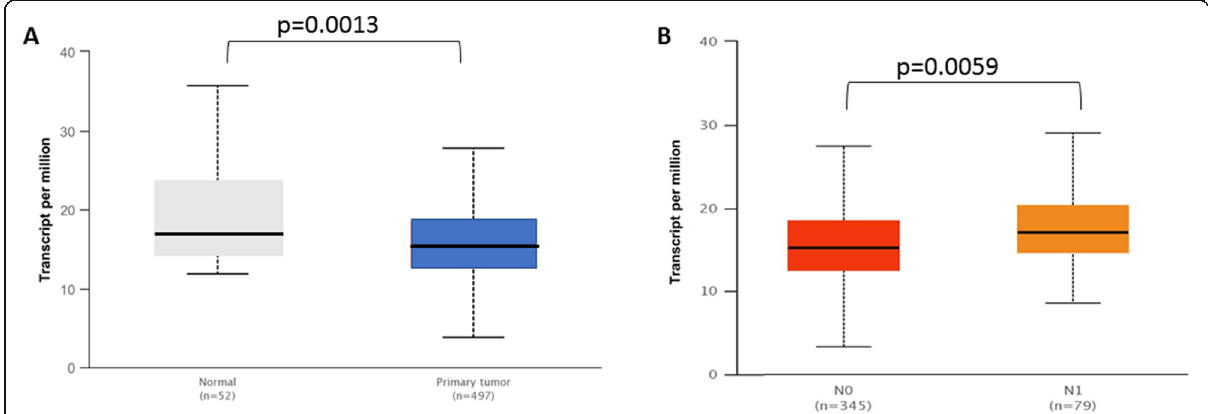
Fig. 3 Gene expression analysis of TERF1 in TCGA cohort. A . Comparison between normal tissue and prostate cancer. B Comparison between tumors that did not invade proximal lymph nodes (N0) and tumors that invade proximal lymph nodes